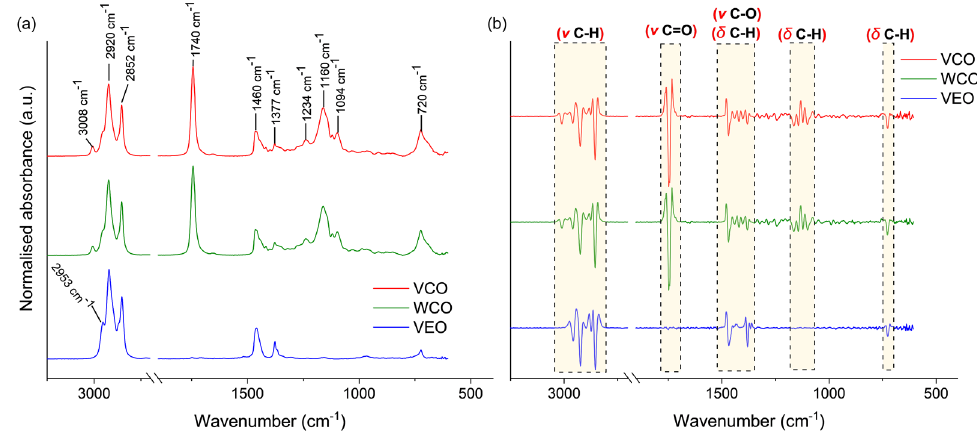
Figure 6. ( a ) FTIR-ATR infrared spectra of VCO, WCO, VEO, and ( b ) second derivative of spectra for VCO, WCO, VEO.